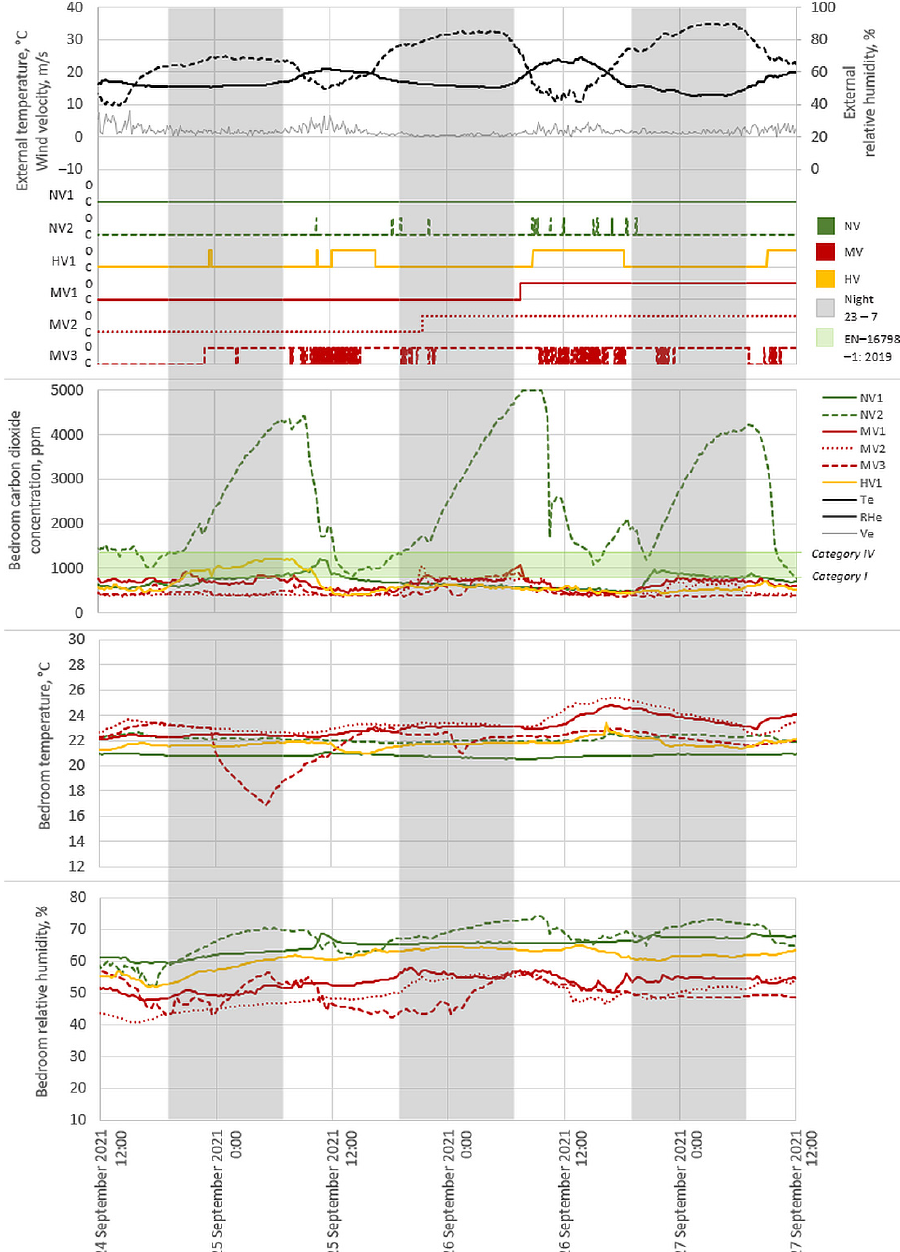
Figure 7. Detailed variability of the measured parameters over the period 24–27 September